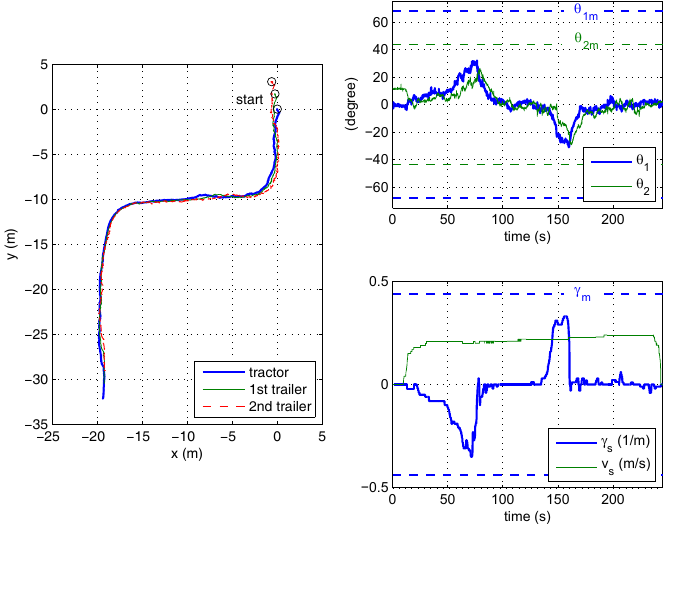
Figure 10. Forward driving with the off/off axle setup: paths of the tractor and trailers ( left ); hitch angles with corresponding mechanical limits ( top right ); driver commands and curvature limitations ( bottom right